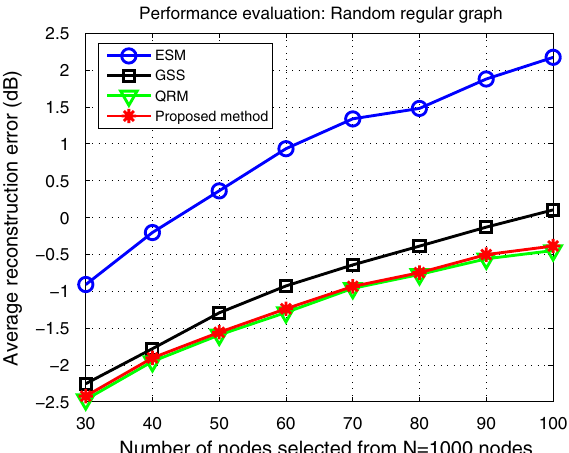
Fig. 3 Performance evaluation for noisy non‑bandlimited graph signals on RRG with σ = 0.1 by varying the sample size, | S